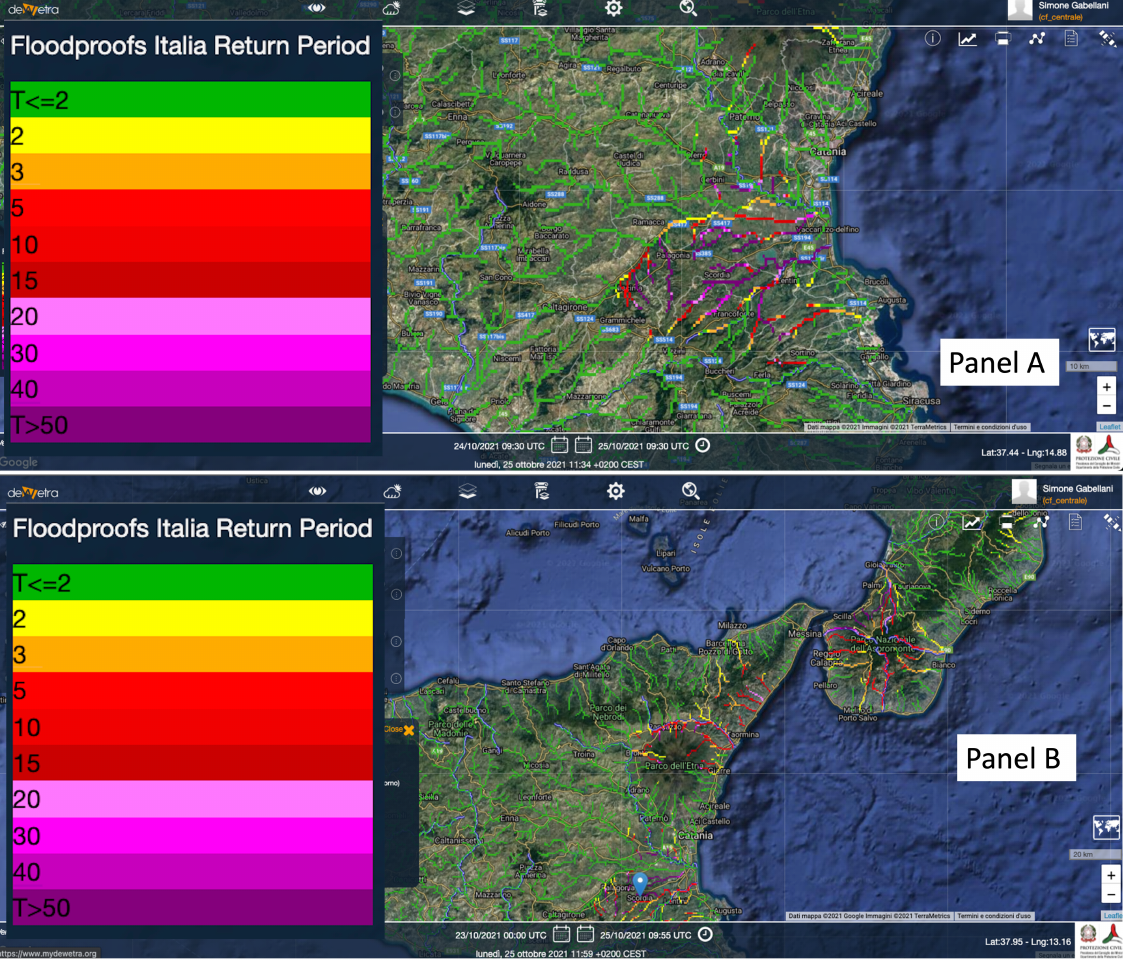
Figure 7. OCTOBER 25 at 09:30 UTC: FloodPROOFS—Event severity expressed as discharge return period estimated according to model climatology. This monitoring tool of the modeling chain highlights the most severely affected areas (run on observations). ( A ): Catanian plain, Scordia, and Ogliastro (Catania). ( B ): Messina and Reggio